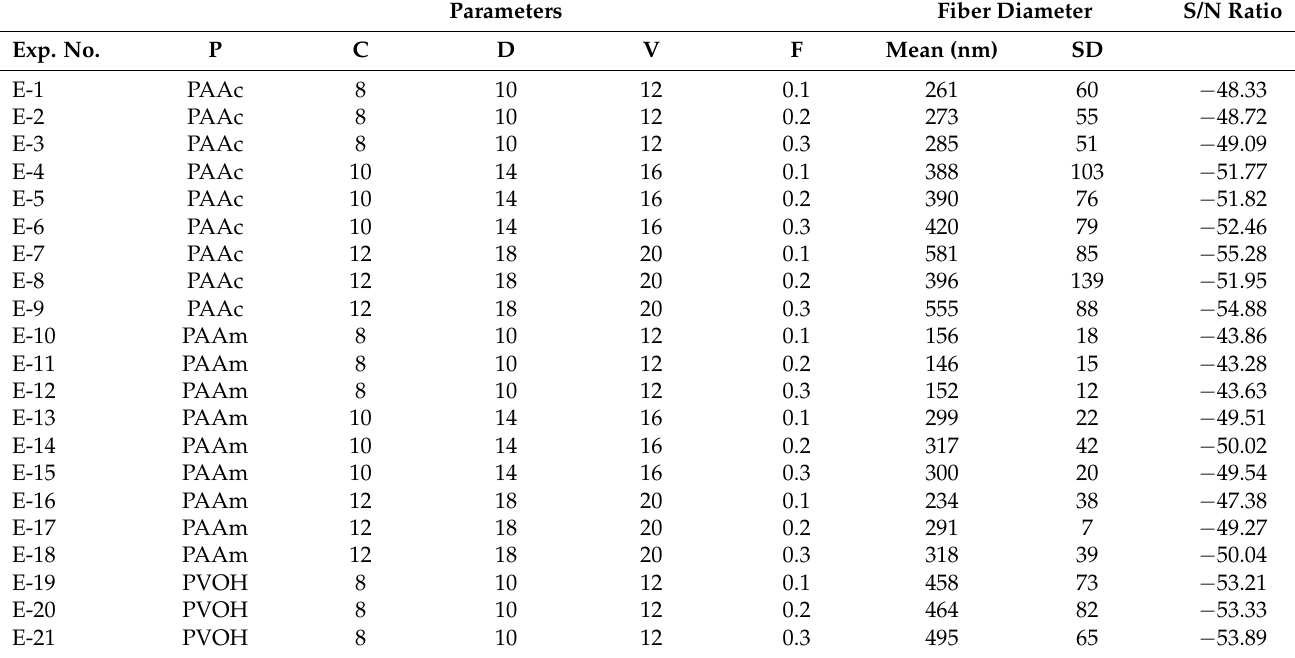
Table 2. Experimental design with mean nanofiber diameter (nm), standard deviation (SD) and signal-to-noise ratio